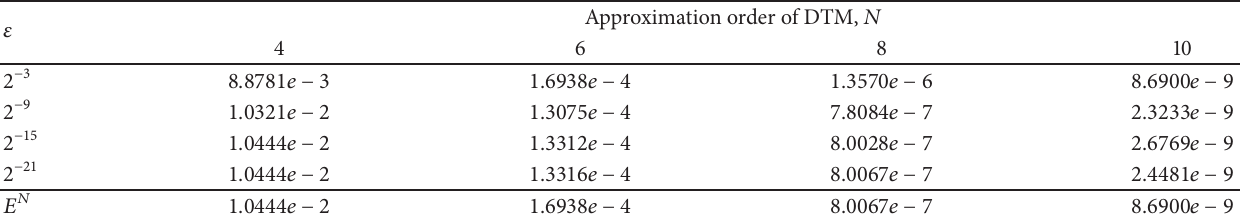
Table 3: Maximum pointwise errors 𝐸 𝑁 𝜀 and 𝐸 𝑁 for the first derivative solution 𝑦 2, ap of Example 1.